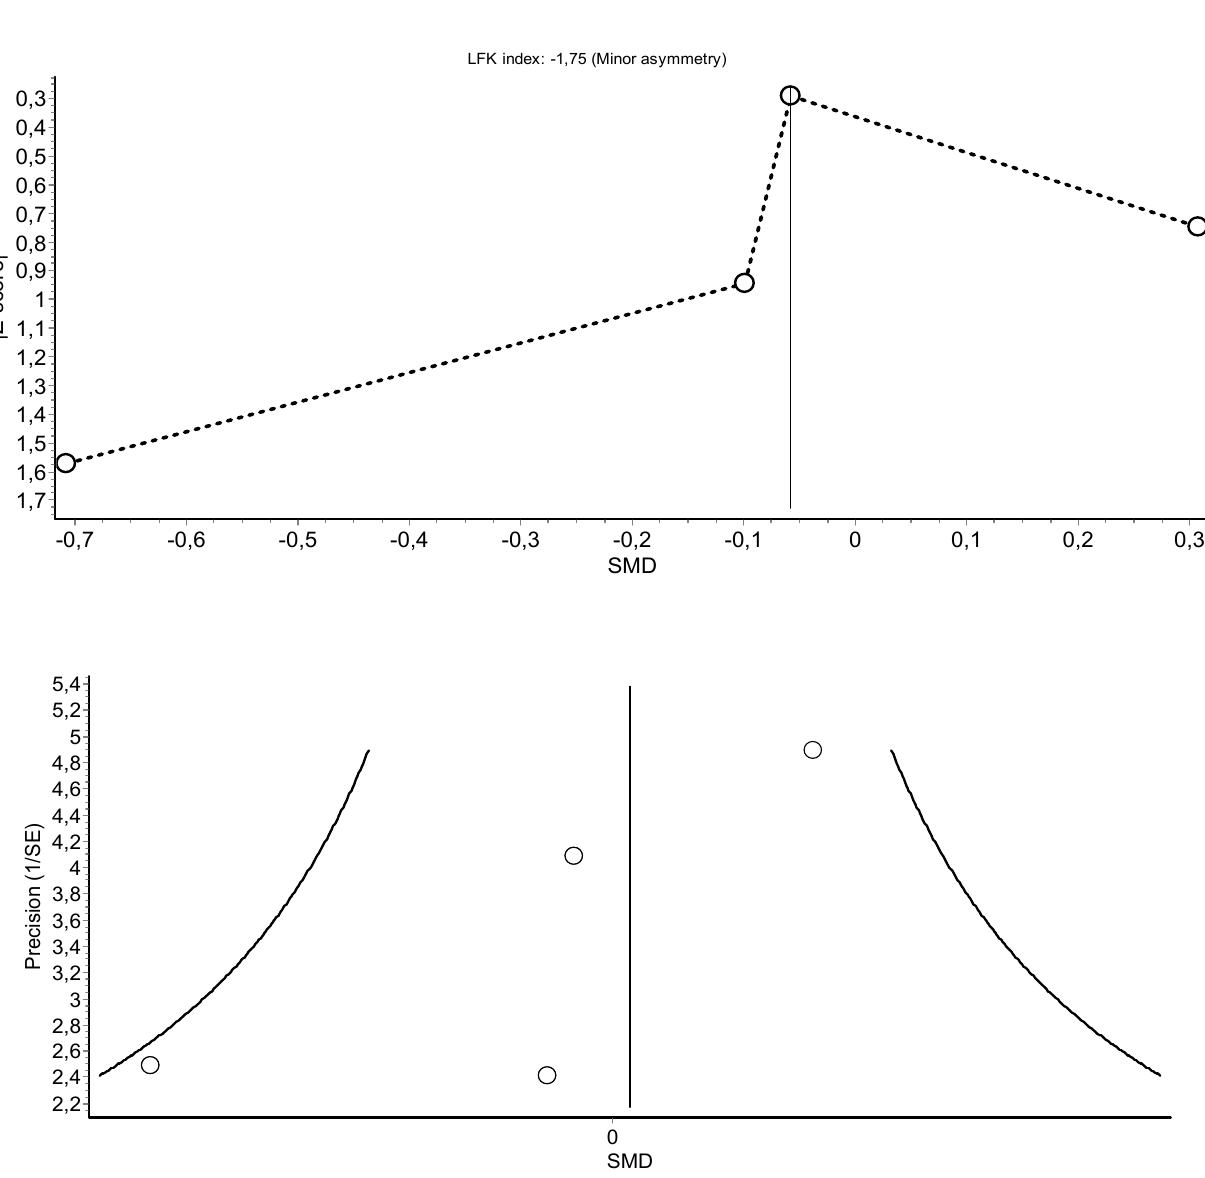
Figure A11. Synthesis funnel and Doi plot (LFK index) for muscle mass.